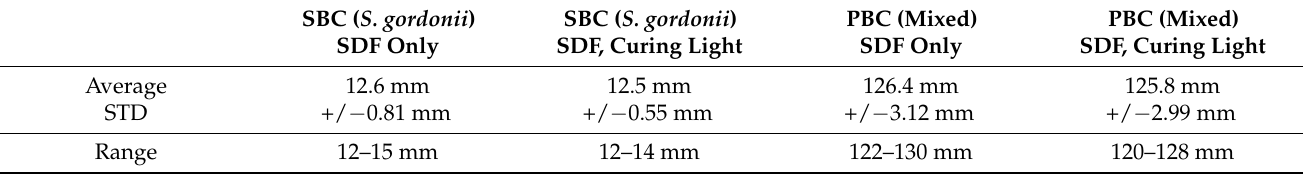
Table 2. ZIT-AA measurements for the single Gram-negative (SBC) and polybacterial cultures (PBC). SBC ( S. gordonii